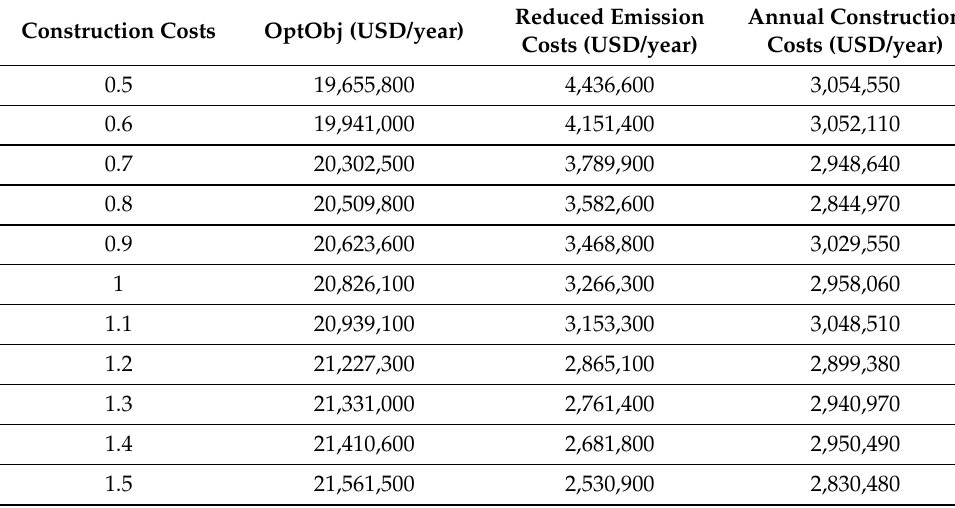
Table 4. Results of sensitive analysis on bunkering station construction costs.